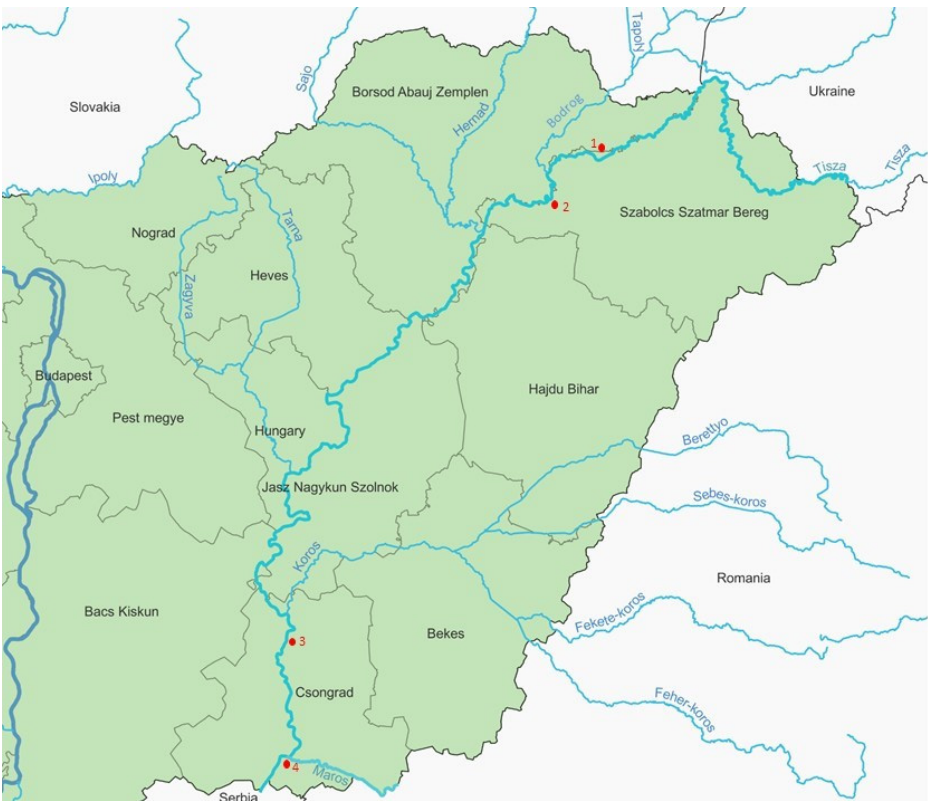
Figure 1. Hydrographic map of Tisza River and its tributaries arriving from Slovakia (Bodrog, Sajó) and Romania (Körös, Maros). The four sampling sites located at settlement Tímár ( 1 ), Tokaj ( 2 ), Csongrád ( 3 ), and Szeged ( 4 ) are marked with red circles.